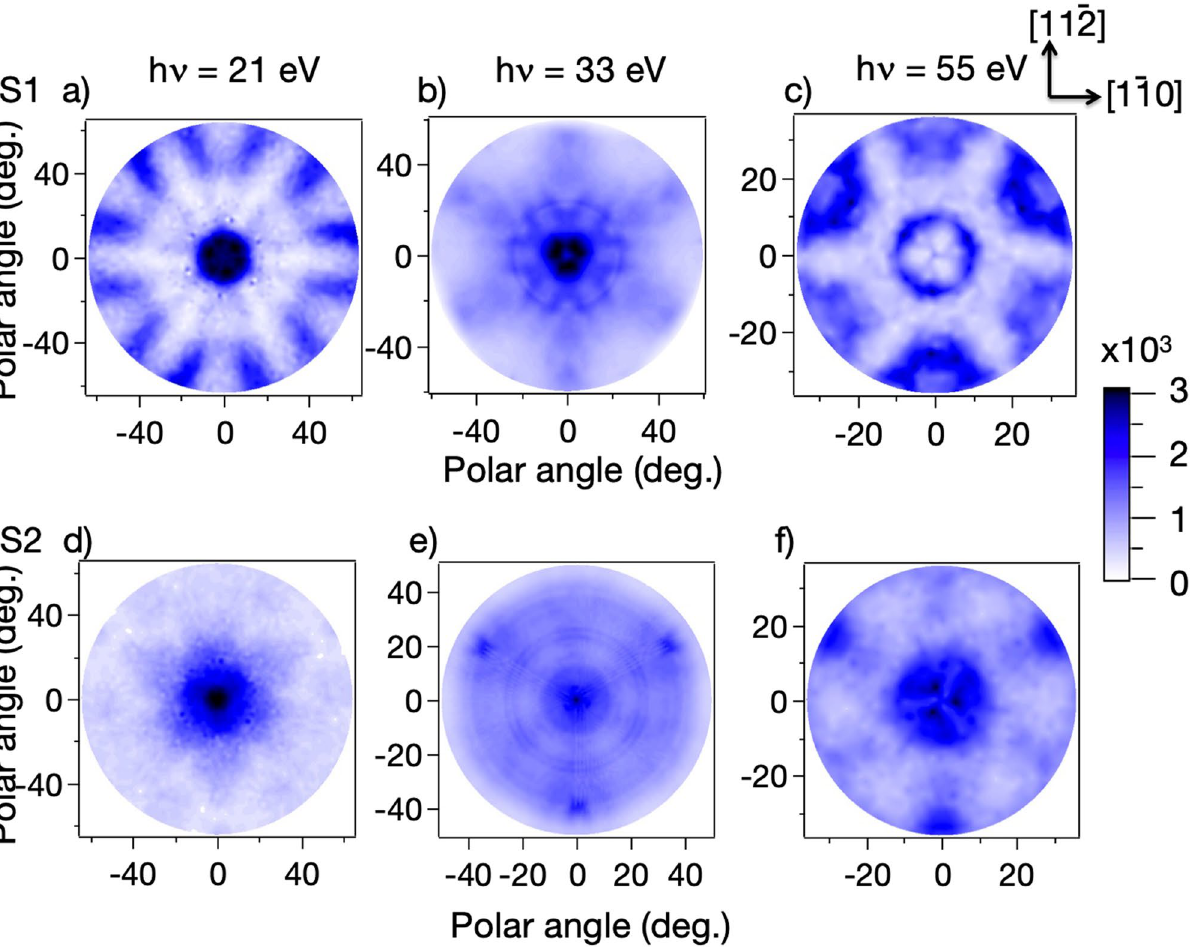
Figure 4. Stereographic projections of the intensity of photoemission from the S1 represented in panels ( a – c ) and S2 in panels ( d – f ) surface states on Si(111)(7 × 7) at three different photon energies (21 eV, 33 eV and 55 eV respectively). All the holograms have been recorded using the setup I of Figure